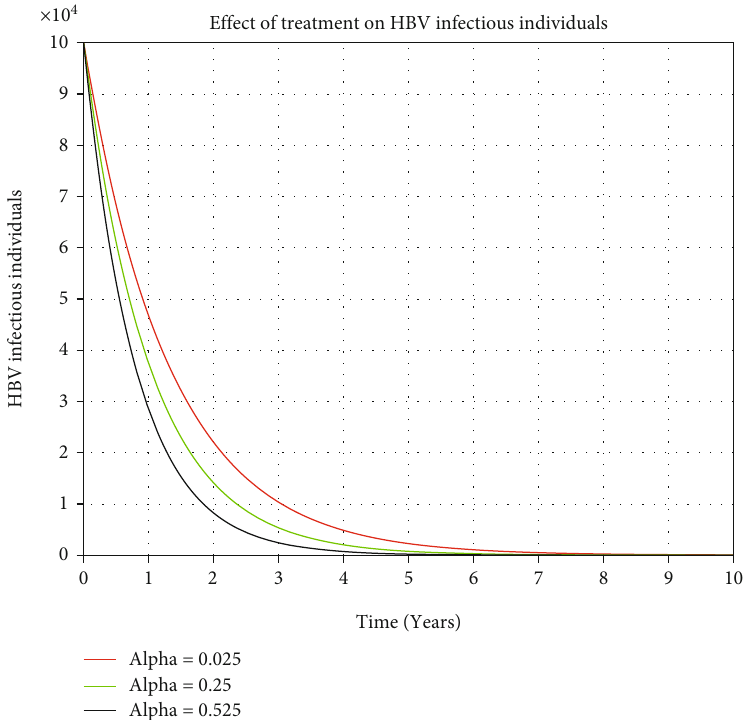
Figure 10: The e ff ect of treatment on HB infectious individuals.